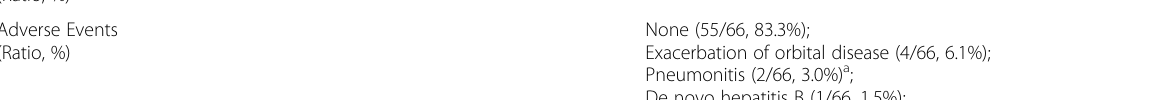
None (55/66, 83.3%); Exacerbation of orbital disease (4/66,